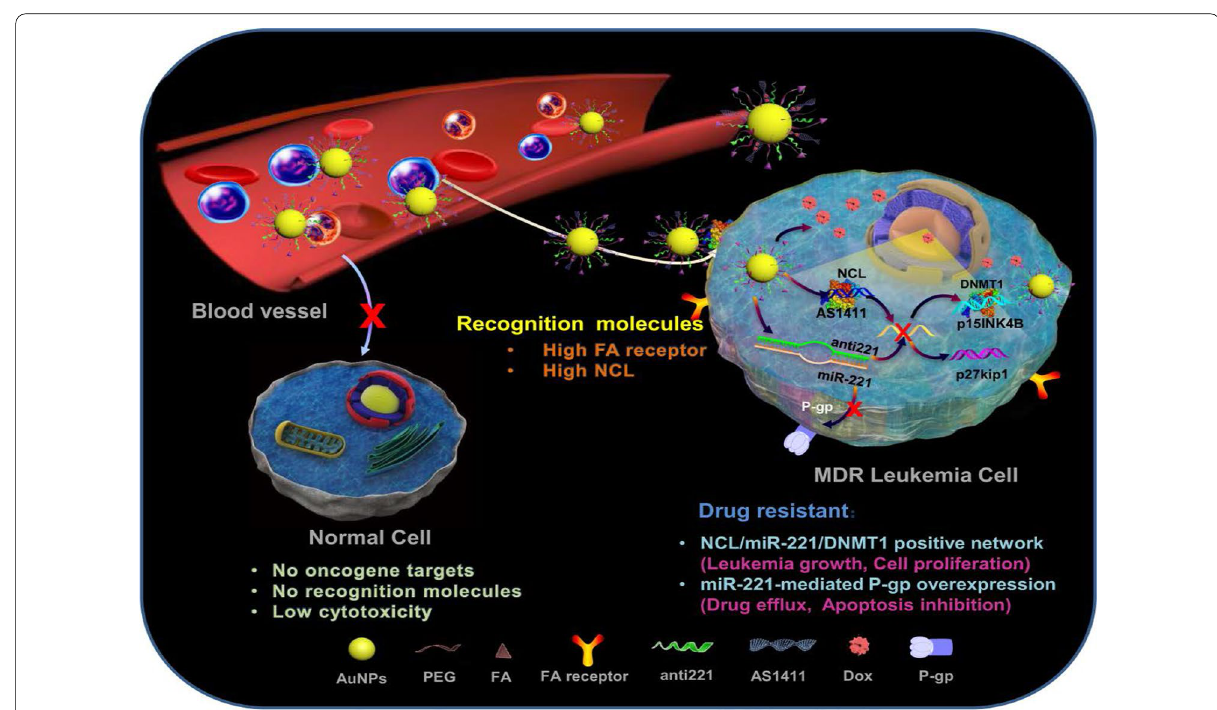
Fig. 7 Multifunctional AuNPs in the treatment of multidrug-resistant (MDR) leukemia cells by increasing the sensitivity of the cells to Dox. Reproduced with permission [11]. Copyright 2019. Springer Nature. Folate (FA)